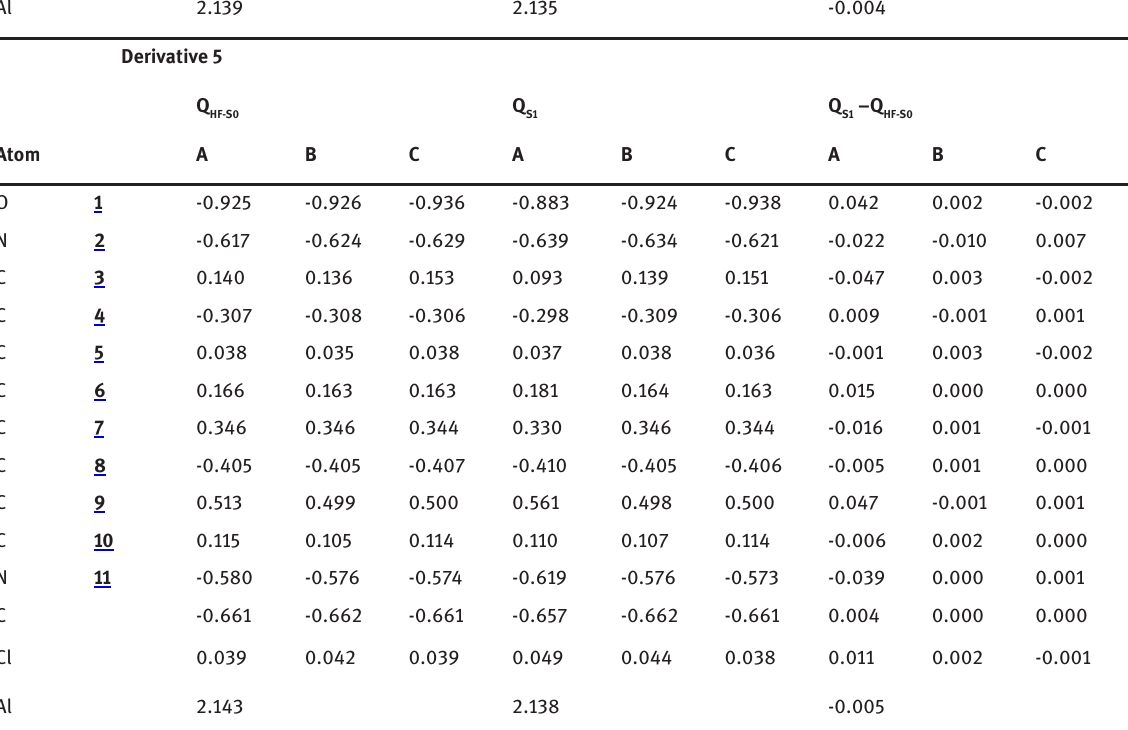
) and first excited (Q ) states structures and the charge HF-S0 S1